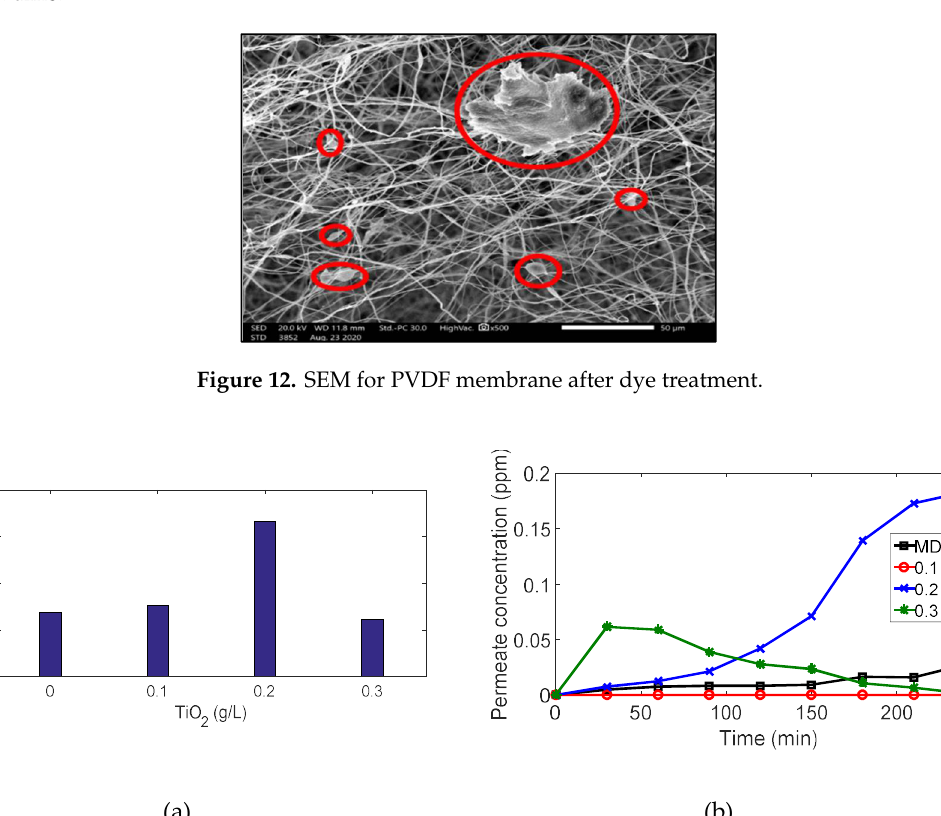
Figure 11. Results for 7 ppm MB experiments: ( a ) flux vs. amount of TiO 2 ; ( b ) permeate concentration vs. time.